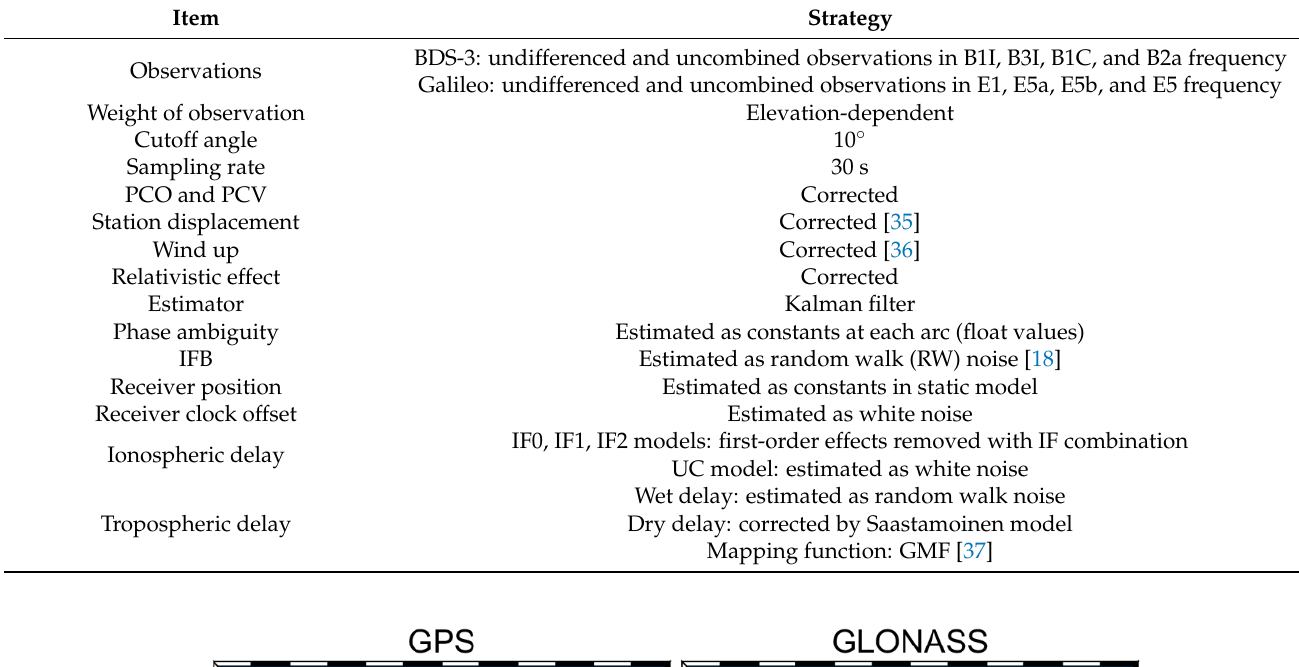
Table 4. Strategies for BDS-3 and Galileo IF0, IF1, IF2, and UC PPP time transfer model.